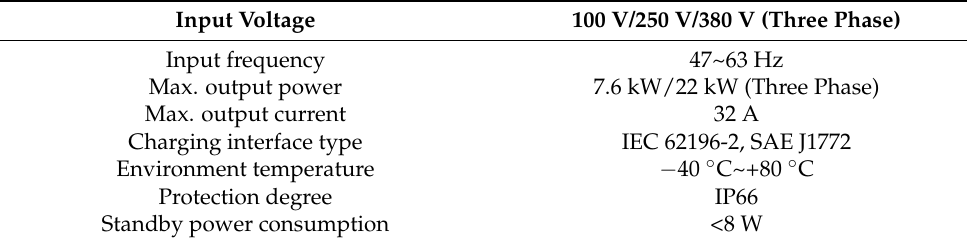
Table 3. Manufacturer data for charger type used in this research